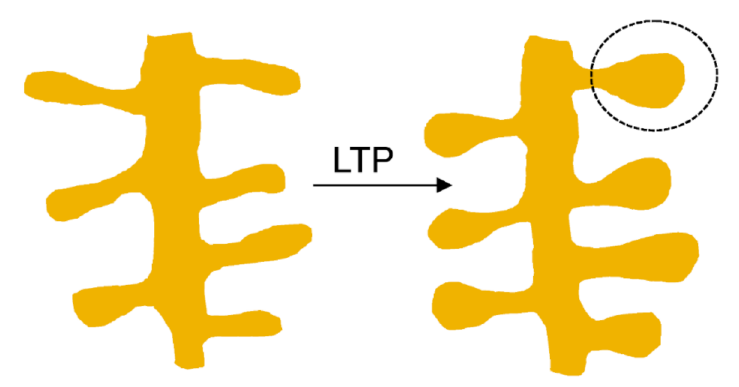
Figure 2. Schematic depiction of the enlargement and acquisition of mature mushroom-like shape of dendritic spines following induction of long-term potentiation (LTP) during synaptic plasticity.